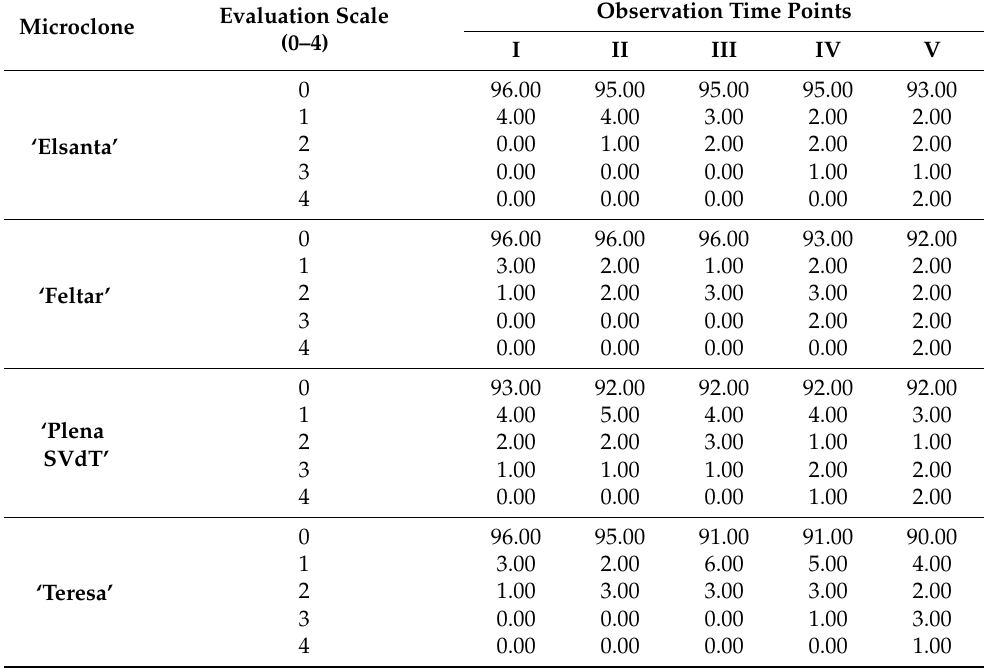
Table 3. Percentage of microplants with chlorosis among control strawberry microclones at subse- quent observation time